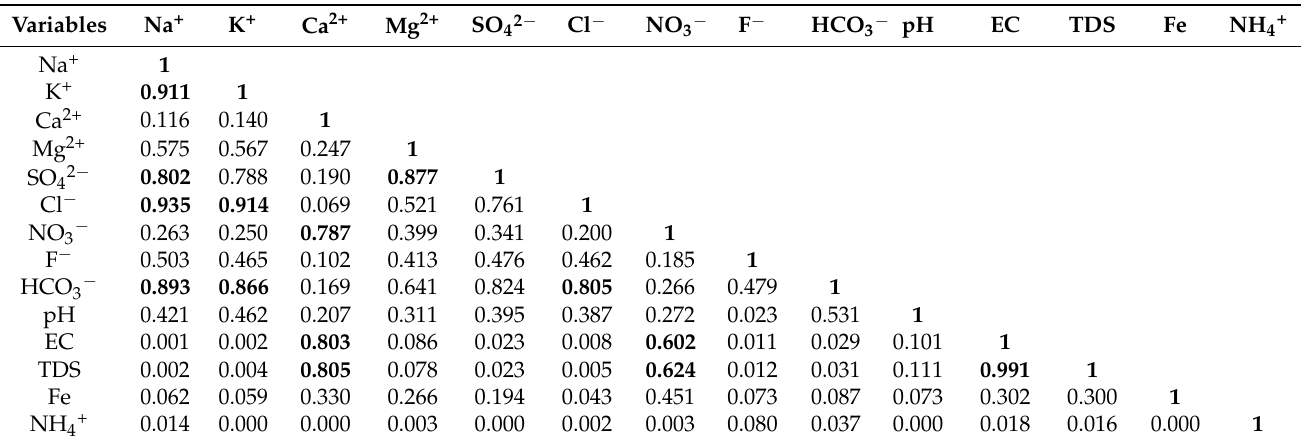
Figure 3. Mechanism controlling groundwater chemistry ( a ) TDS versus (Na + + K + )/(Na + + K + + Ca 2+ ); ( b ) TDS versus Cl − /Cl − + HCO 3 − . A plot of HCO 3 − + SO 42 − versus HCO 3 − (Figure 4a) indicates the presence of weather with carbonic acid, an important source of bicarbonate ions in the aquifer with a strong cor- relation coefficient (r = 0.824; R 2 = 0.7745) (Table 3), as was reported in similar studies [59]. Table 3. Correlation matrix for the groundwater samples. (Values in bold have p -value <